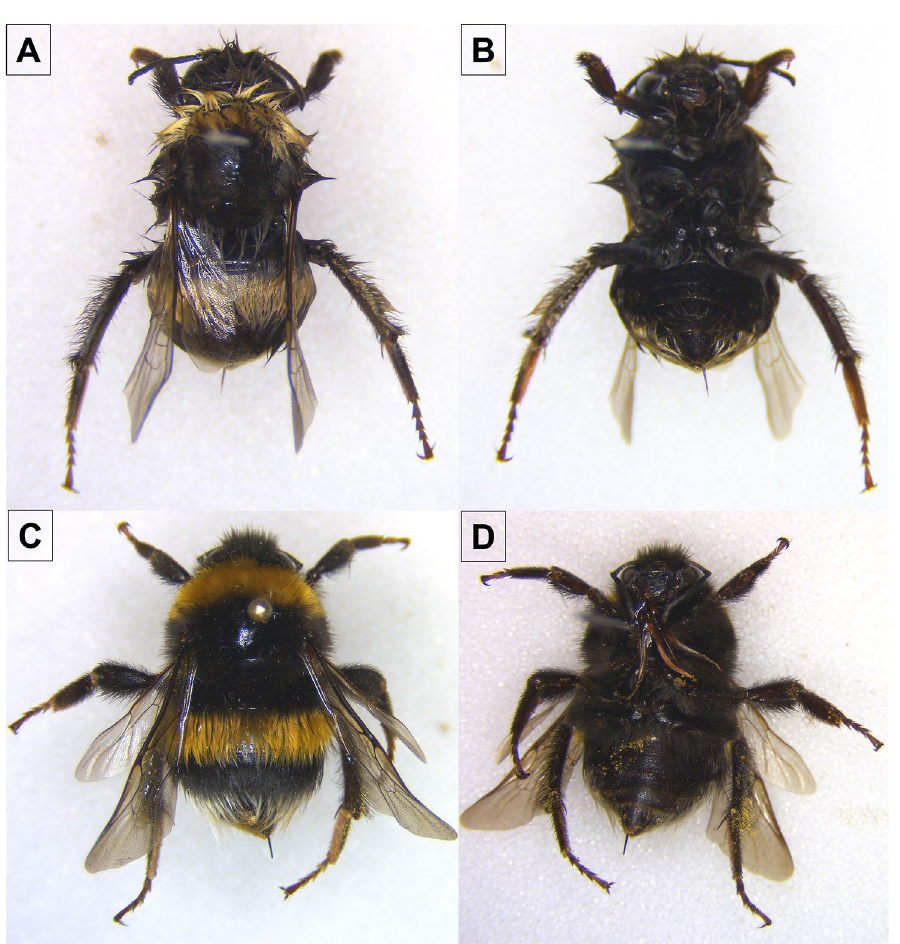
Figure 2. Dorsal and ventral comparison between the post-treatment in two Bombus terrestris individuals using the Gilbert et al. 13 ( A , B ) and the here proposed ( C , D )